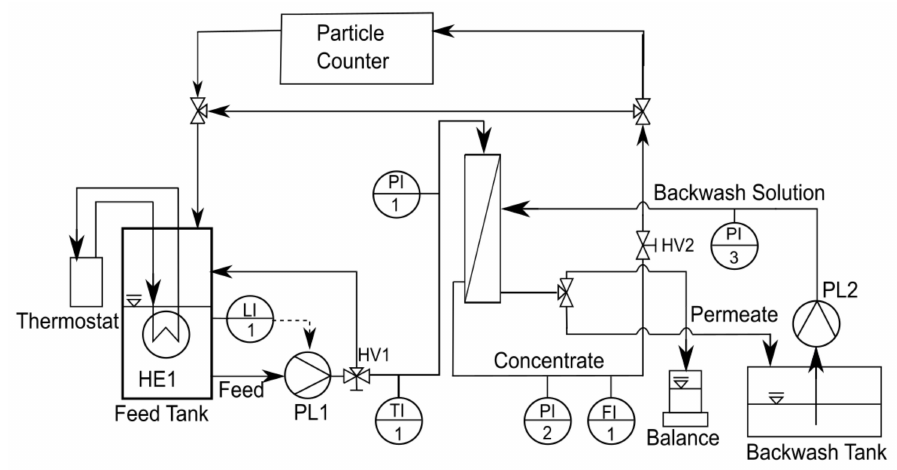
Figure 2. Filtration